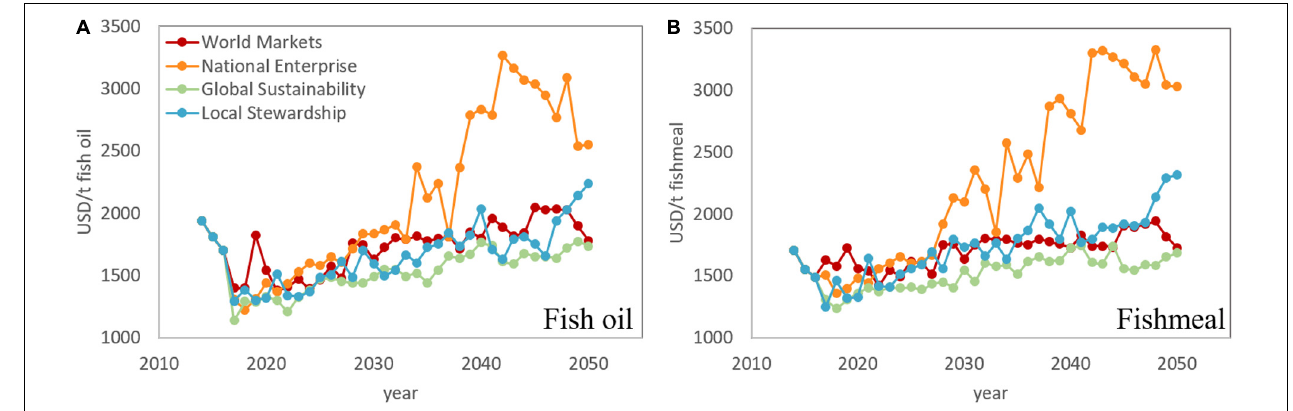
FIGURE 3 | Future price development of fish oil (A) and fishmeal (B) in USD/ton under the four climate change and European aquatic resources (CERES) scenarios.